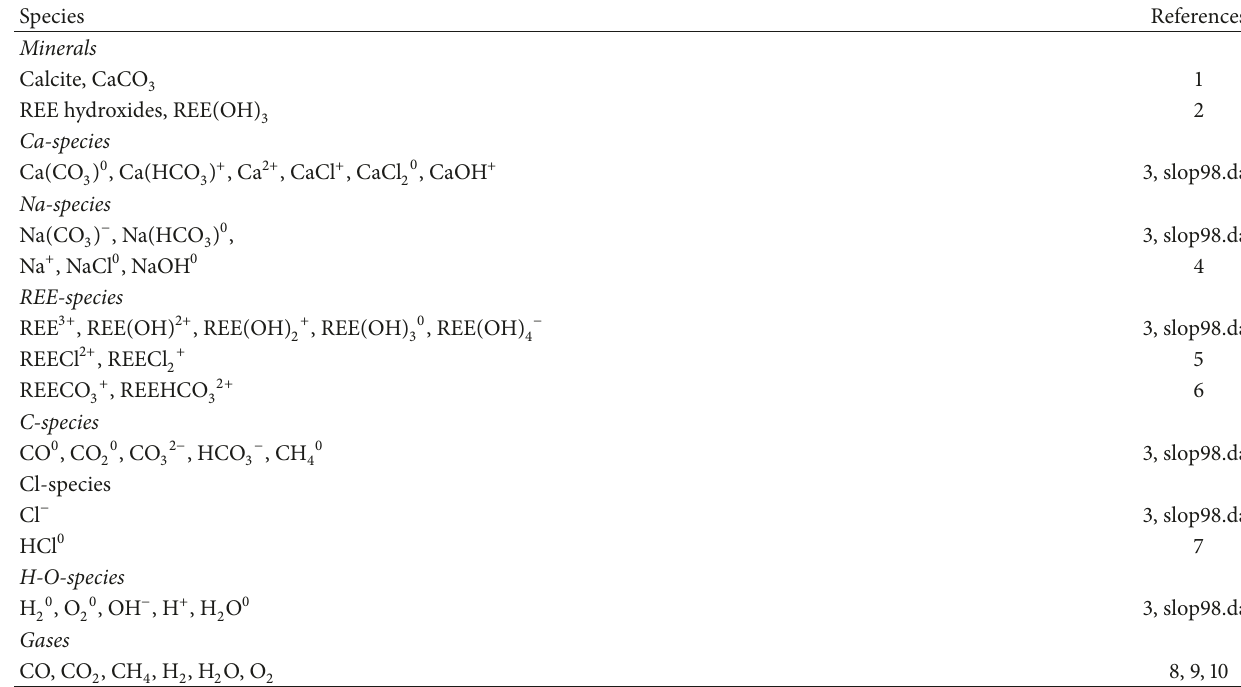
Table 2: Source of thermodynamic data for minerals, aqueous species, and gases included in the numerical simulations.